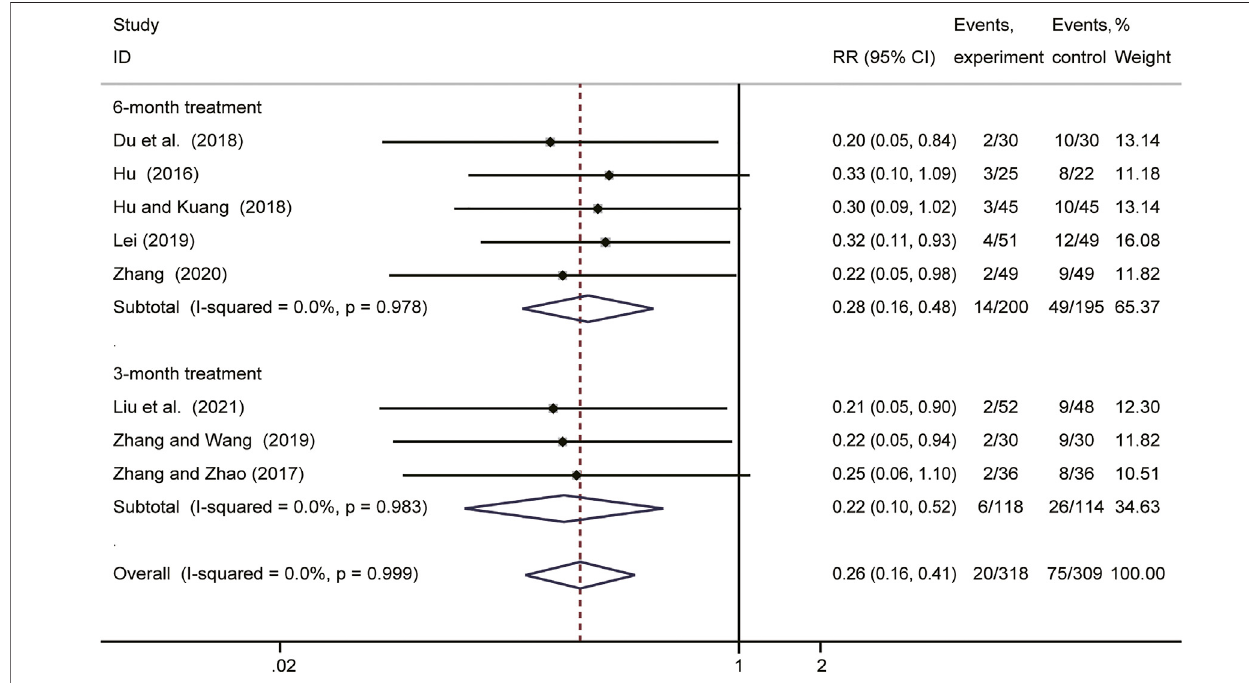
FIGURE 6 | Forest plot of the effect of different durations of postoperative Salvia -containing CHM combined with GnRH-a treatment in preventing endometriosis recurrence.